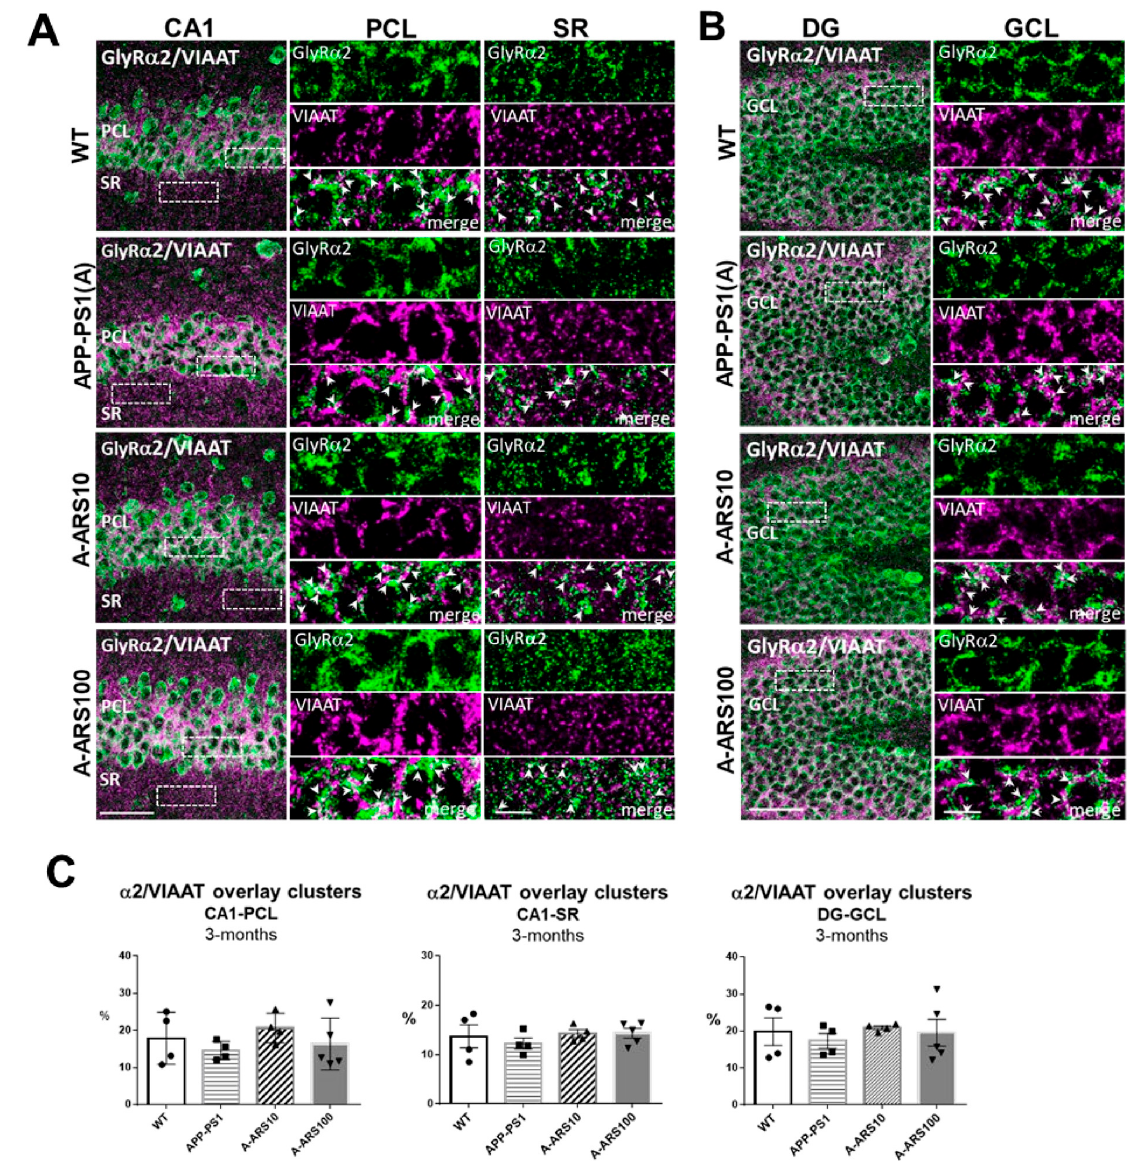
Figure 2. Subcellular localization of GlyR α 2 clusters in hippocampus sections of 3-month-old WT and APP/PS1 mice. ( A , B ) Representative double channel IF images of the CA1 region ( A ) and the dentate gyrus (DG) ( B ) of WT, APP/PS1 and APP/PS1 mice treated with two different doses (10 mg/kg and 100 mg/kg) of artesunate (A-ARS10, A-ARS100). Brain cryosections were double labeled with an anti-GlyR α 2 (green) and an anti-VIAAT (magenta) antibody. Right rectangular panels are magnifications of the boxed windows within the pyramidal cell layer (PCL) and the stratum radiatum (SR) of the CA1 region and granule cell layer (GCL) of DG, respectively, showing single channel acquisitions (GlyR α 2, VIAAT) and merged images. Arrows in merged images point to overlapping clusters, indicating putative synaptic localized GlyR α 2 clusters. Confocal maximum intensity projections (8 optical sections, 3.5-µm thick z-stack; rectangular panels—2 optical sections, 1-µm thick z-stack); scale bars: 50 µm; panels: 10 µm. ( C ) Quantitative analyses of overlapping clusters in hippocampus areas. Note the higher density of GlyR α 2 positive/VIAAT positive clusters in the PCL of low-dose artesunate-treated APP/PS1 mice in comparison to untreated ones. Three randomly chosen fields within PCL and SR of CA1 and two in the dentate gyrus (DG) of each hippocampus were analyzed ( n = 4–5 brains/group). The numbers of overlapping clusters were normalized to the total number of clusters positive for the GlyR α 2 subunit and given as a percent (%). Means ± SEM.